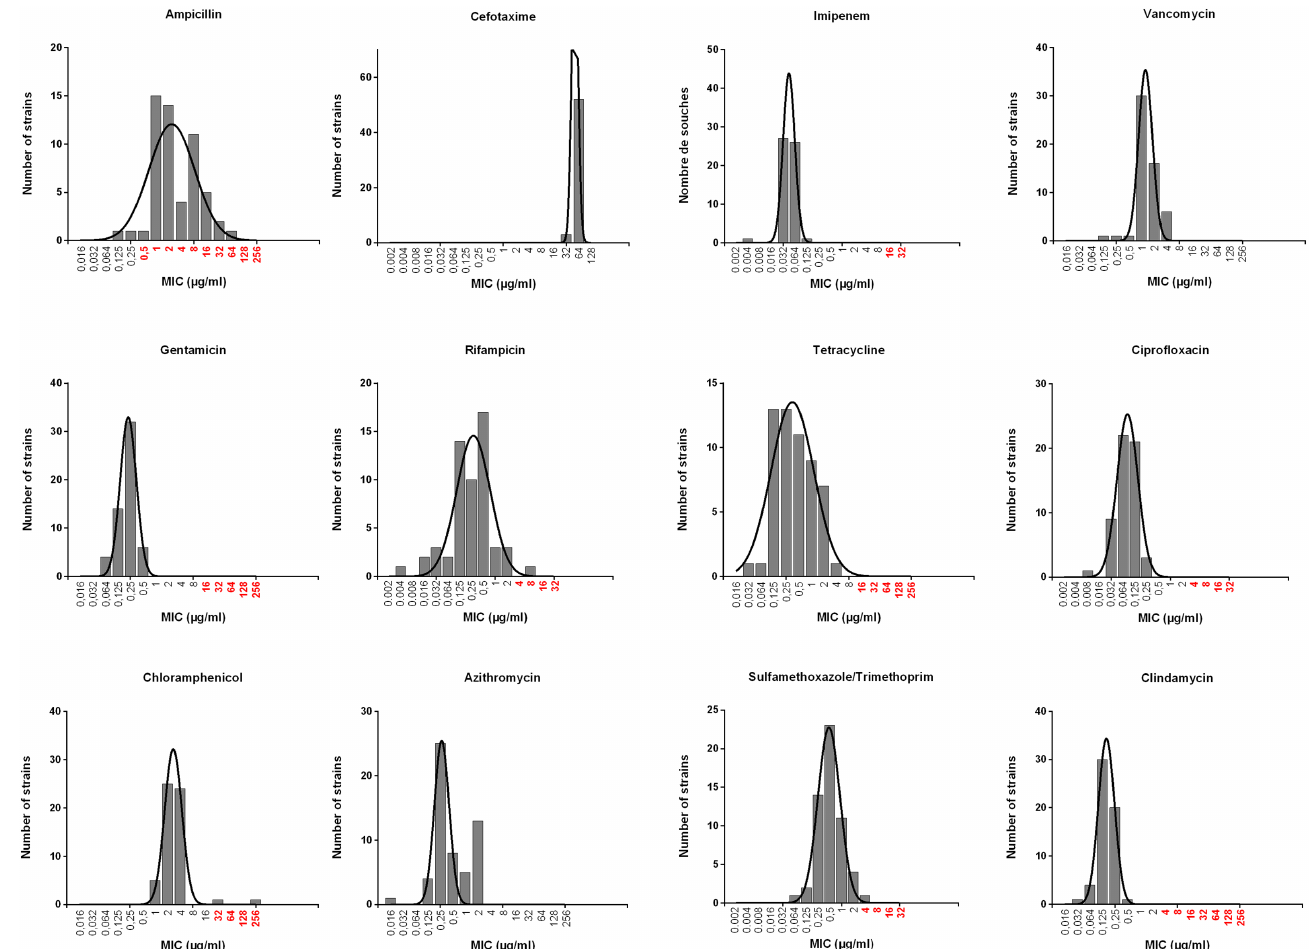
Fig 2. MIC results (Etest method) for the 56 B . cereus strains. Black lines: population distribution. Concentrations indicated in red are classified as clinically resistant according to CLSI or EUCAST (no known values for Azithromycin, cefotaxime and vancomycin).